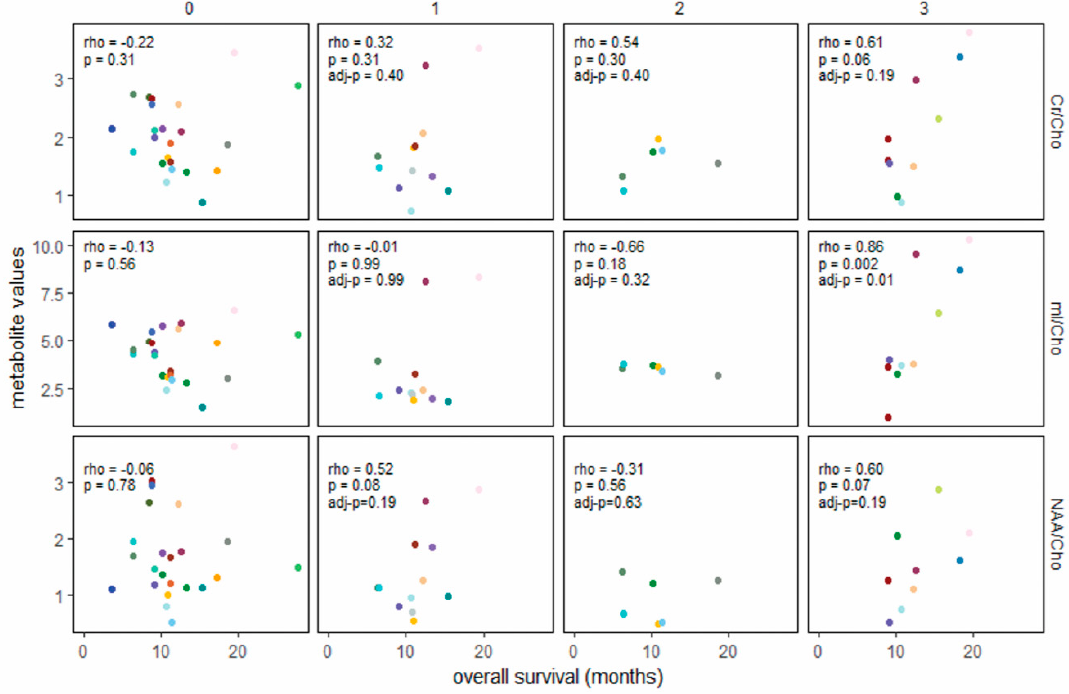
Figure 3. Association between metabolite ratios and overall survival in the non-vaccine cohort, at diagnosis ( n = 23, left column), and at 3 timepoints defined relative to date of diagnosis to align with dosing categories for the vaccine cohort (28 scans within 7.6 months of diagnosis in 19 pa- tients). RT = irradiation with or without concurrent chemotherapy. Spearman rank-order correlations are shown for each panel, with Benjamini–Hochberg control of p -values to a false positive rate of 0.05 for timepoints 1–3. Each color represents an individual patient. 0 = diagnosis, before RT; 1 = 1.9–3.8 months post-diagnosis (post-RT for most); 2 = 4.0–5.2 months post-diagnosis; 3 = 5.3–7.6 months